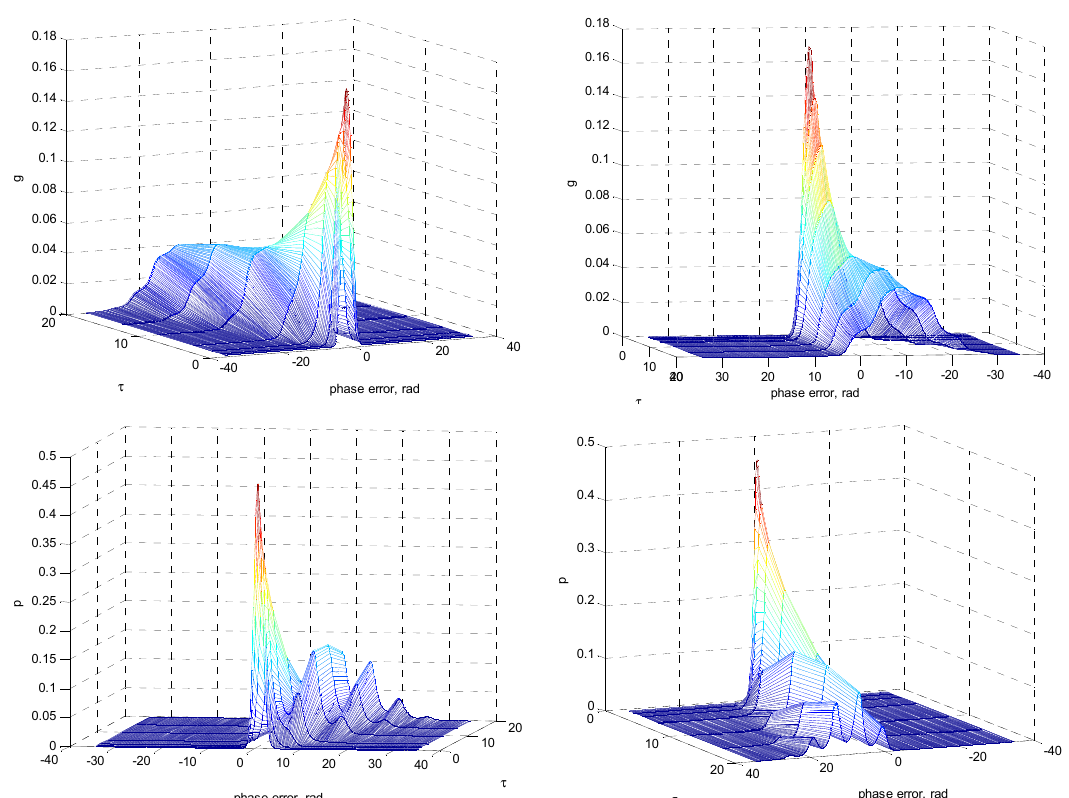
Figure 7. Three-dimensional plots for the nonmodulo-2 π transition g and p , respectively, for SNR α = 1 as time progresses: front view ( left ) and back view ( right ; γ = sin ( π /4 ) ).